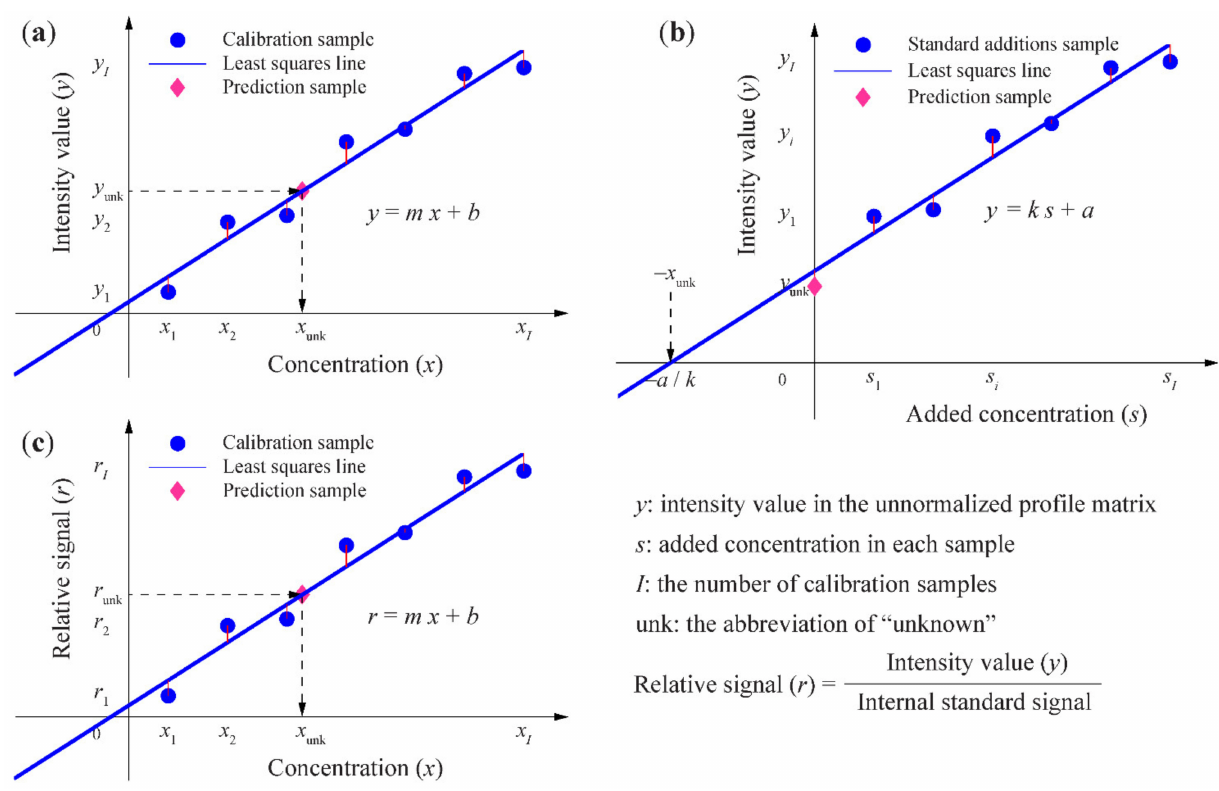
Figure 3. Illustration of the regression steps in ( a ) the multiway calibration method, ( b ) multiway standard additions method, and ( c ) multiway internal standard